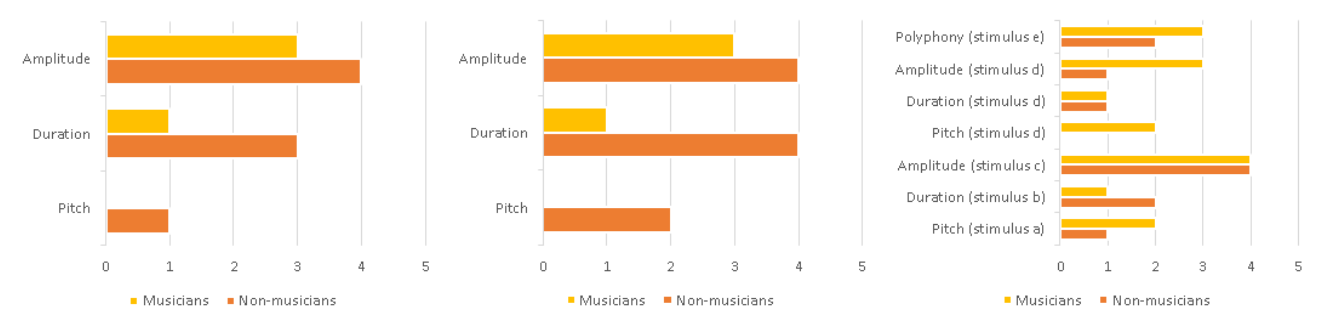
Figure 9. Frequencies of participant gesture mapping change for each phase and between phases 1 and 2; Left : Phase 1 intra-phase mapping changes (stimuli a, b, c to stimulus d); Center : Phase 2 intra-phase mapping changes (stimuli a, b, c to stimulus d); Right : Phase 1 to phase 2 mapping